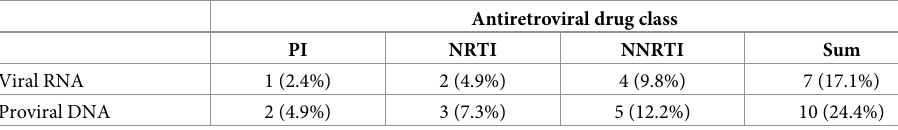
Table 4. Occurrence of polymorphisms at drug resistance